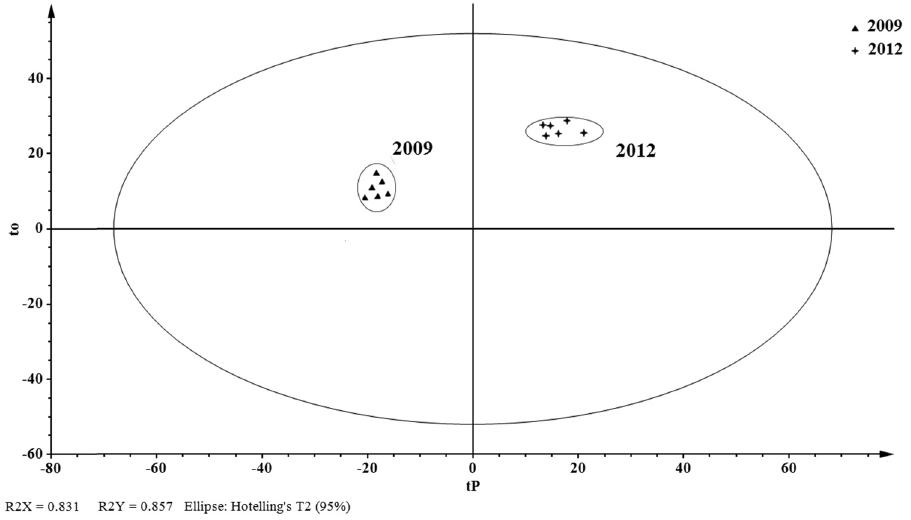
Figure 10: OPLS - DA score plot chart from 1 H NMR spectra of 2009 and 2012 vintage Cabernet Sauvignon